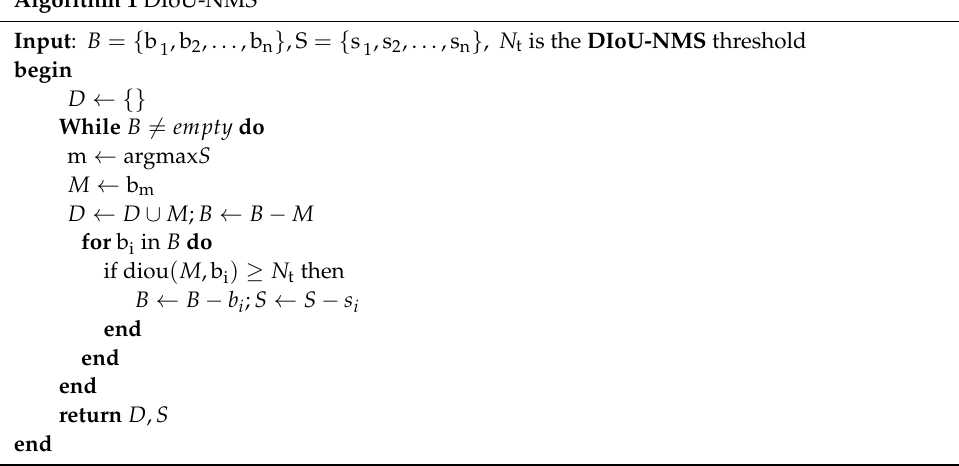
Figure 7. YOLOv5_H network